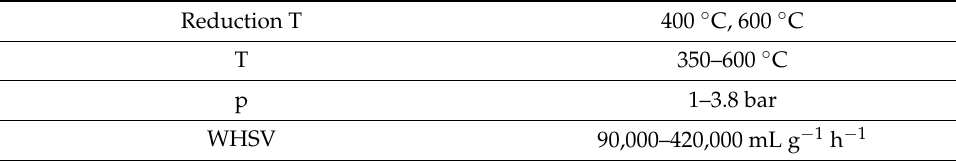
Table 10. Parameters for experiments with Ru0.5/Al 2 O 3 with H 2 /CO 2 = 4 and CH 4 /CO 2 = 50/50